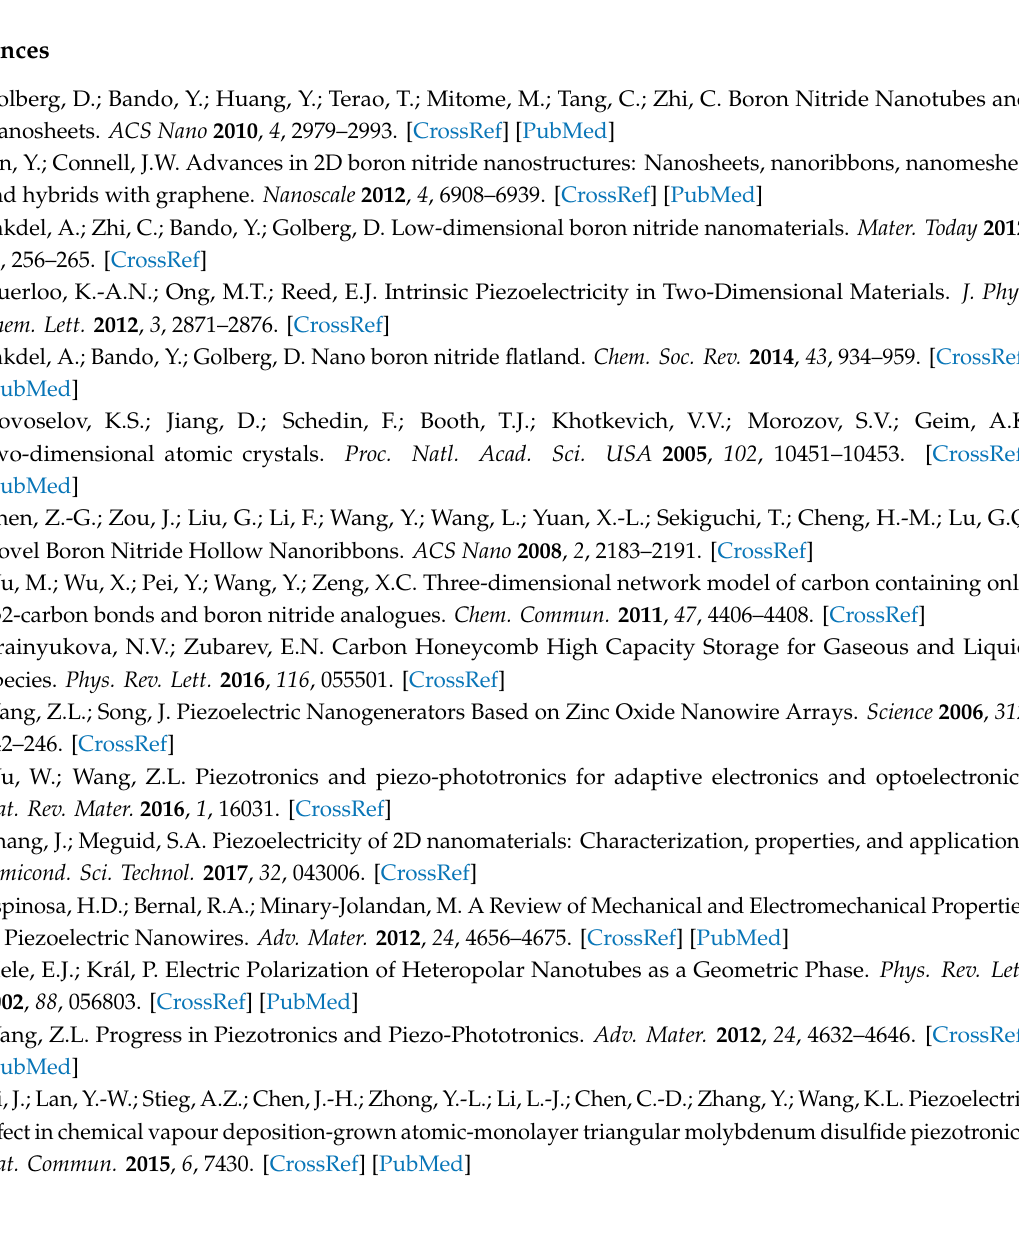
Figure S1: The curves of total energy versus temperature during heating of BNHCs; Video S1: Tensile in zigzag direction; Video S2: Tensile in armchair direction; Video S3: Tensile in cell axis